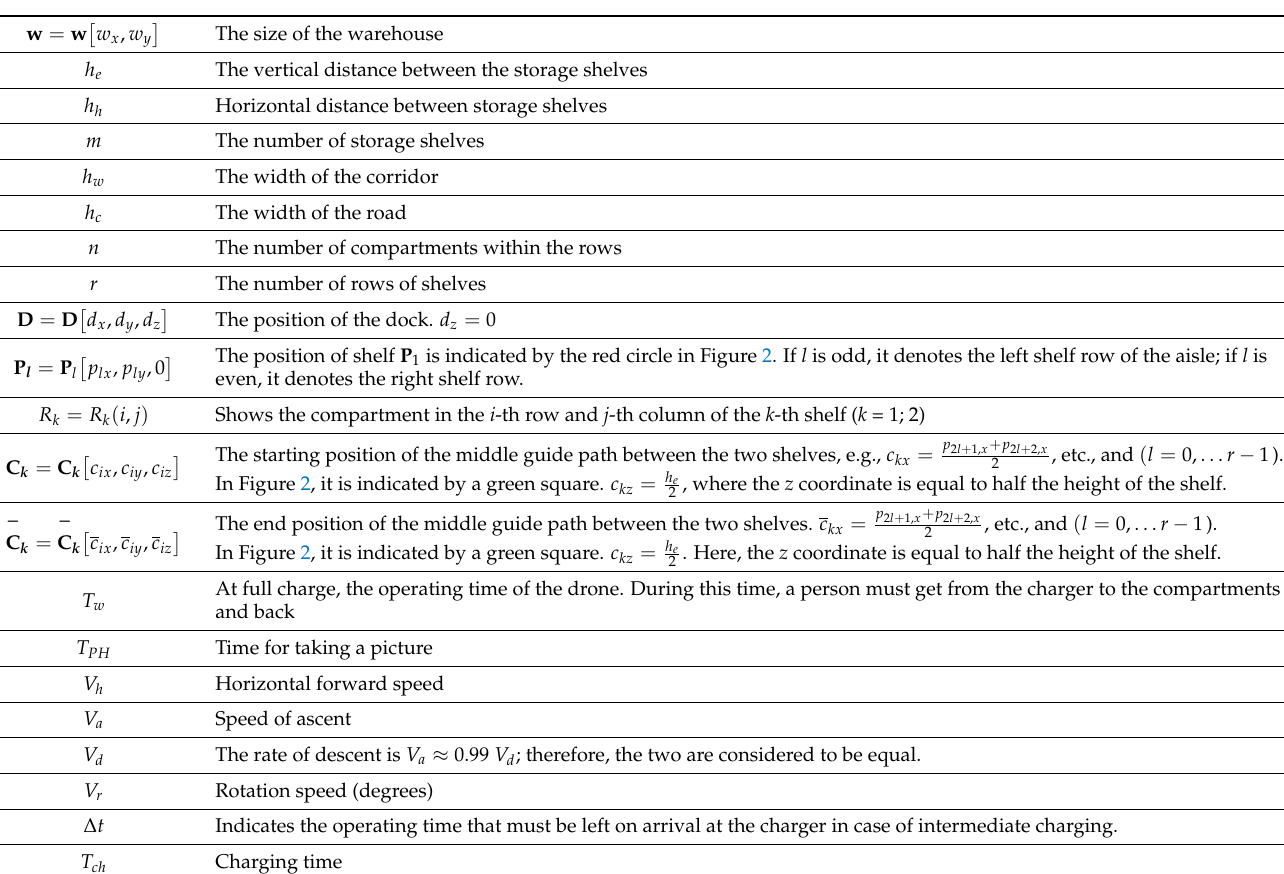
Table 1. Summary and notation of known